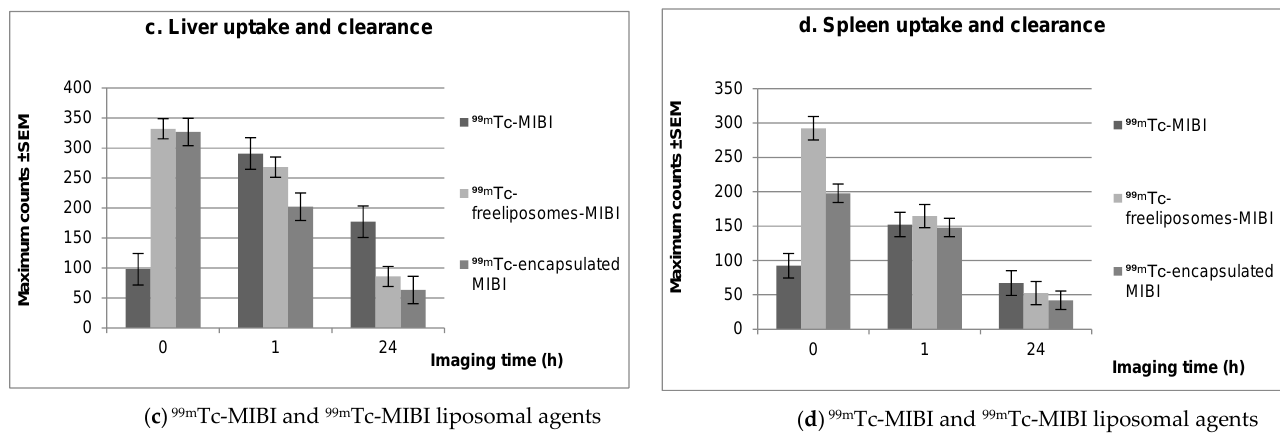
Figure 3. 99m Tc-MIBI, 99m Tc-free liposome-MIBI, and 99m Tc-encapsulated MIBI pharmacokinetics in the heart, bowel, liver, and spleen in the blood-pool, 1 h, and 24 h post-injection images using ROI maximum counts ± standard error of mean. Table 1. Blood-pool biodistribution of 99m Tc-MIBI compared to that of 99m Tc-liposomal agents in different organs.